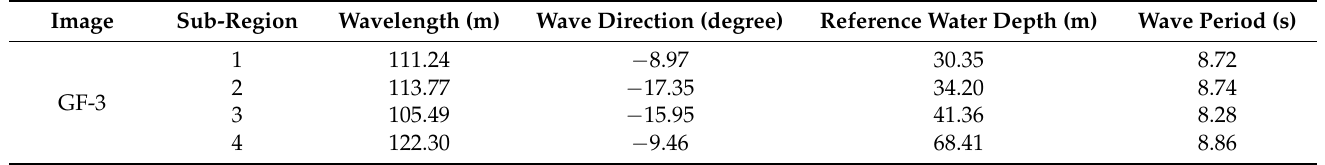
Figure 4. The locations of sub-regions. The yellow boxes represented the sub-region locations of GF-3, and the red, green, and black boxes represented Sentinel-1, ALOS PALSAR, and ENVISAT ASAR, respectively. Table 2. The wave parameters and reference water depths of sub-regions.